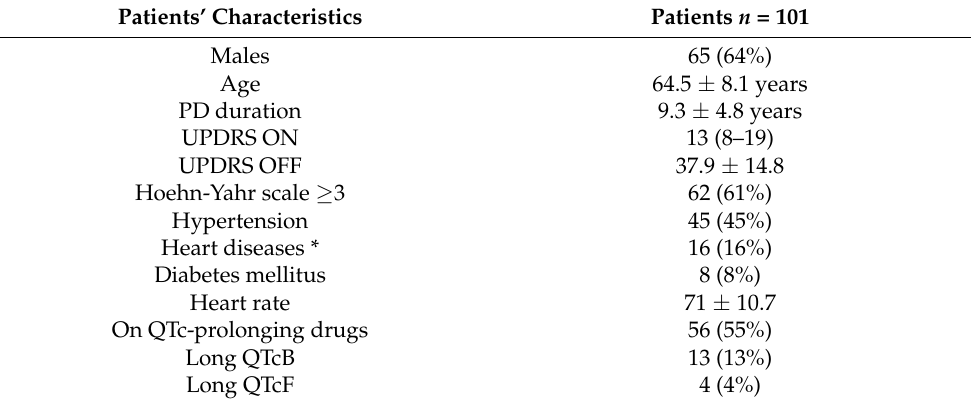
Table 1. Patients’